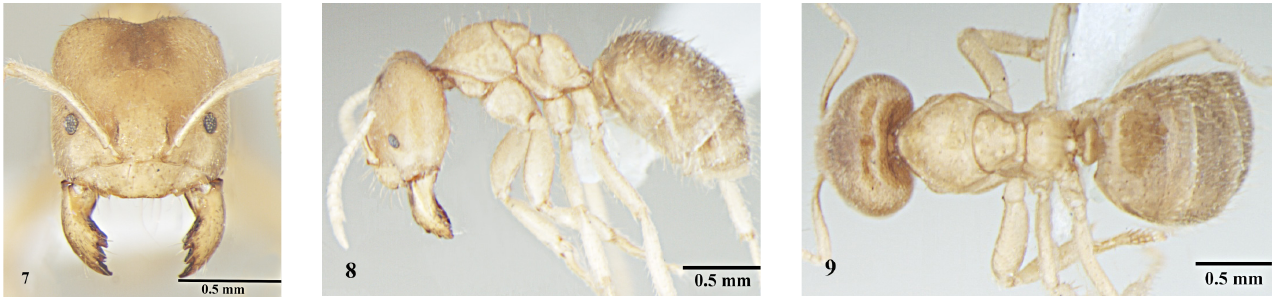
Fig. 7-9. Pseudolasius diversus sp. n ., minor worker 7) head, full face view; 8) body, lateral view; 9) Body, dorsal view.